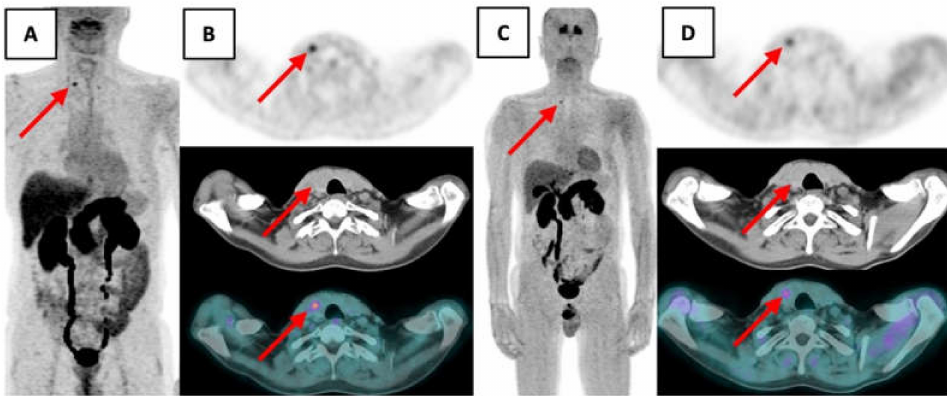
Figure 2. 18 F-FDOPA PET/CT showed a punctiform focus of the right thyroid lobe at the superior part of the nodular bulge suspected of MTC (red arrow).( A ) Maximum intensity projection 12 min post-injection. ( B ) Transaxial PET, CT and fusion PET/CT 12 min post injection. ( C ) Maximum intensity projection 79 min post-injection. ( D ) Transaxial PET, CT and fusion PET/CT 79 min post